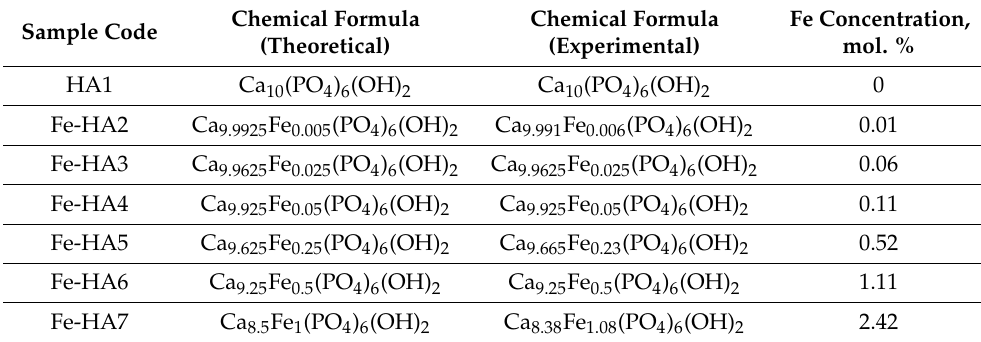
Table 1. Powders chemical theoretical and experimental